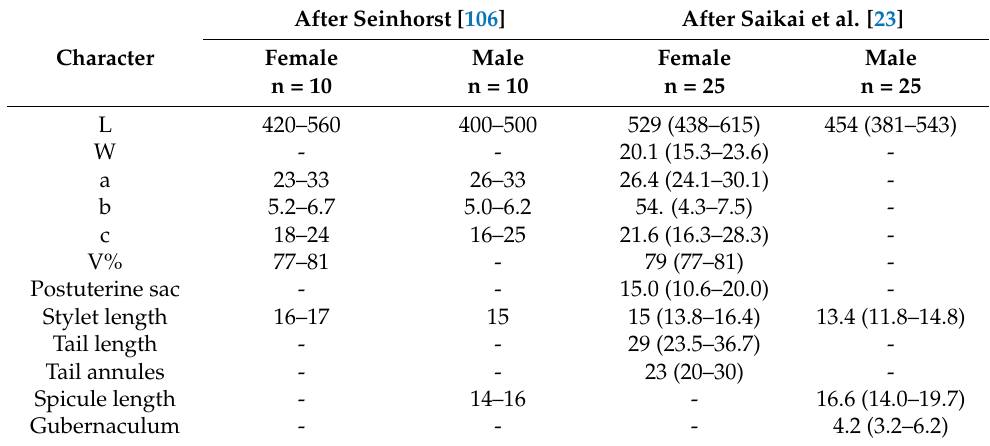
Table 7. Morphometrics of Pratylenchus fallax Seinforst, 1968. All measurements are given in µ